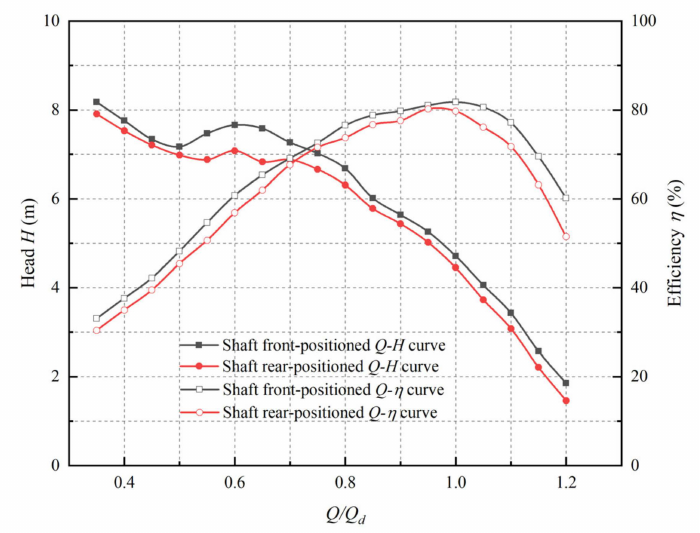
Figure 7. The performance comparison between shaft front-positioned and shaft rear-positioned tubular pump